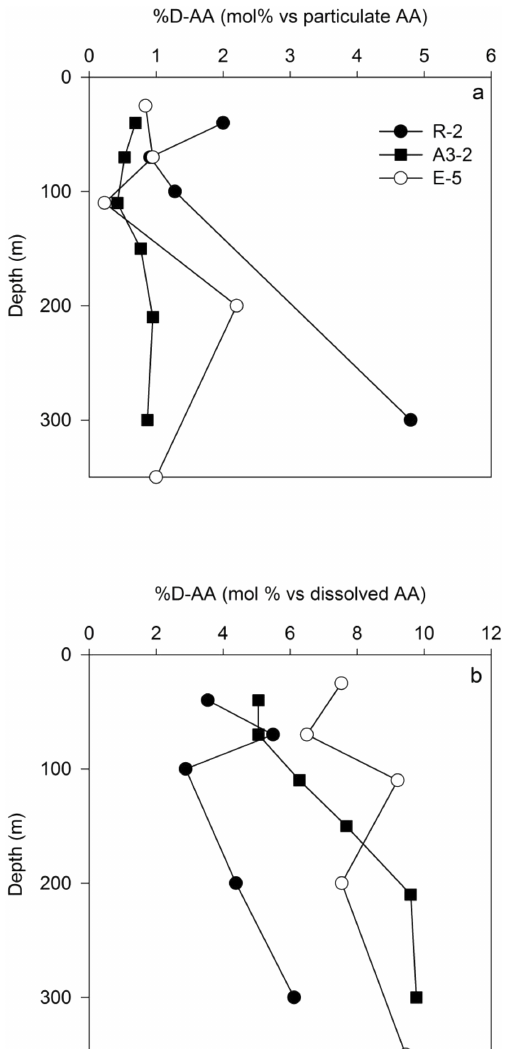
Figure 4. DI of (a) POM (Dauwe et al., 1999) and (b) DOM (Peter et al., 2012) calculated for three representative stations (R-2, A3-2, E-5) at 0–350m depth. Values close to the station R-2 profiles are the next data point at